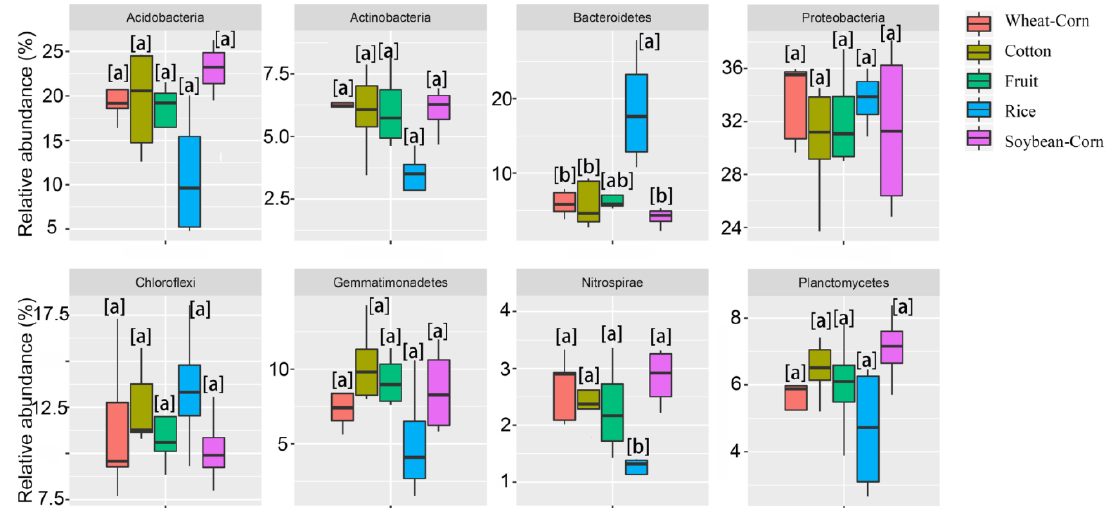
Figure 4. Boxplots representing the relative abundance of the eight domain bacterial phyla discovered in the five cropping systems: wheat corn rotation (Corn–Wheat), cotton (Cotton), rice (Rice),